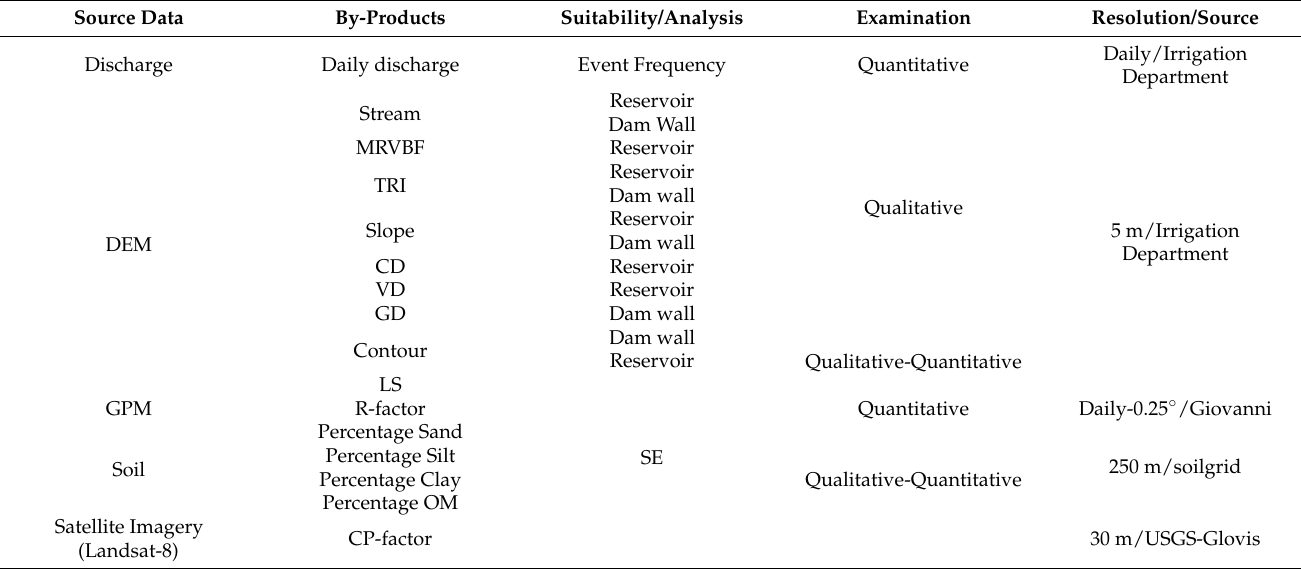
Table 2. Dataset used for dam suitability and Revised Universal Soil Loss Equation (RUSLE)